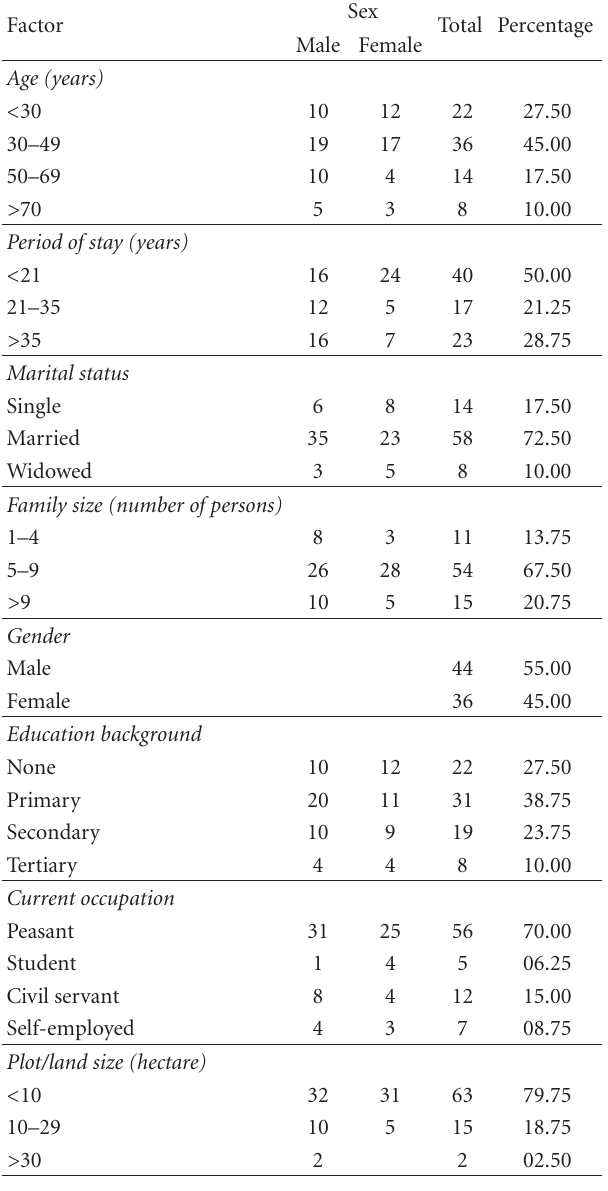
Table 1: Socioeconomic characteristics of the respondents ( N =